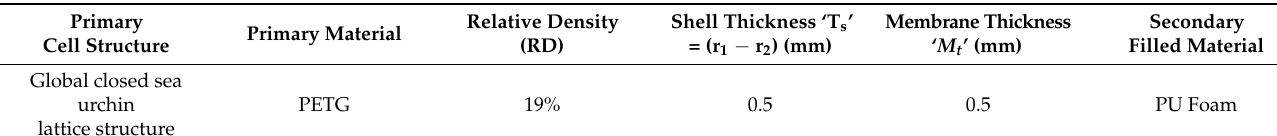
Figure 1. ( a ) Overhang angle and ( b ) Bridge distance for PETG material.